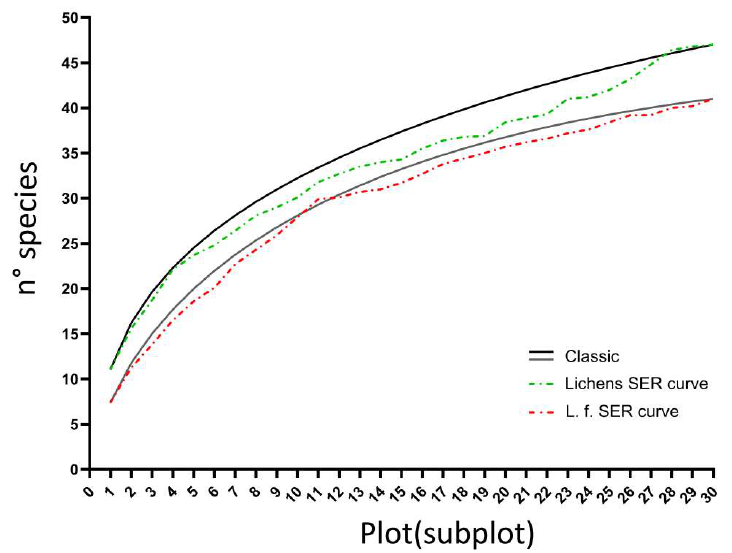
Figure 1. Rarefaction curves: classic (grey line) and spatially explicit rarefaction (SER) curves for the two species groups of lichens (red dotted line) and lichenicolous fungi (green dotted